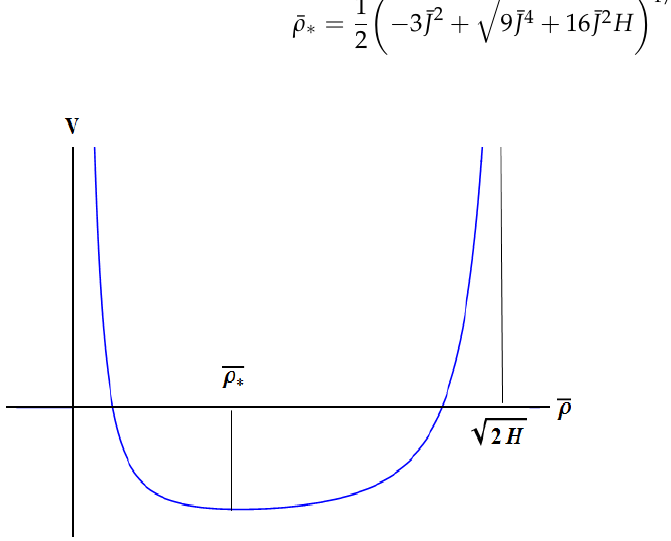
Figure 3. Pseudo-potential V from Equation (45).